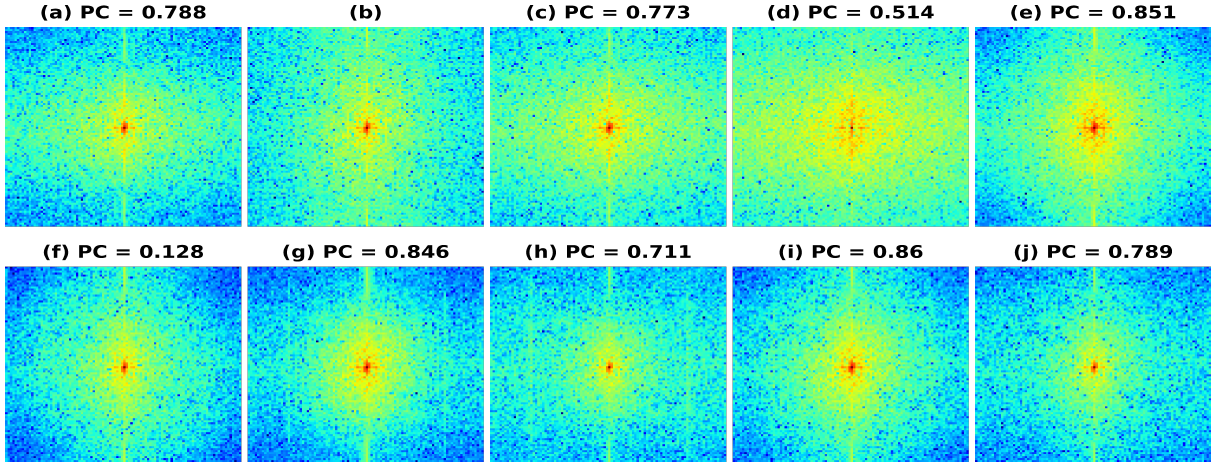
Figure 10. Results of the frequency spectrum of the bandwidth improvement for Phantom II for the different models ( a ) Band-limited image ( b ) Full Bandwidth image ( c ) Histogram Equalization ( d ) Contrast Limited Adaptive Histogram Equalization ( e ) U-Net-PL1 ( f ) U-Net-PL2 ( g ) SRCNN-PL1 ( h ) SRCNN-PL2 ( i ) REDNet-PL1 ( j )